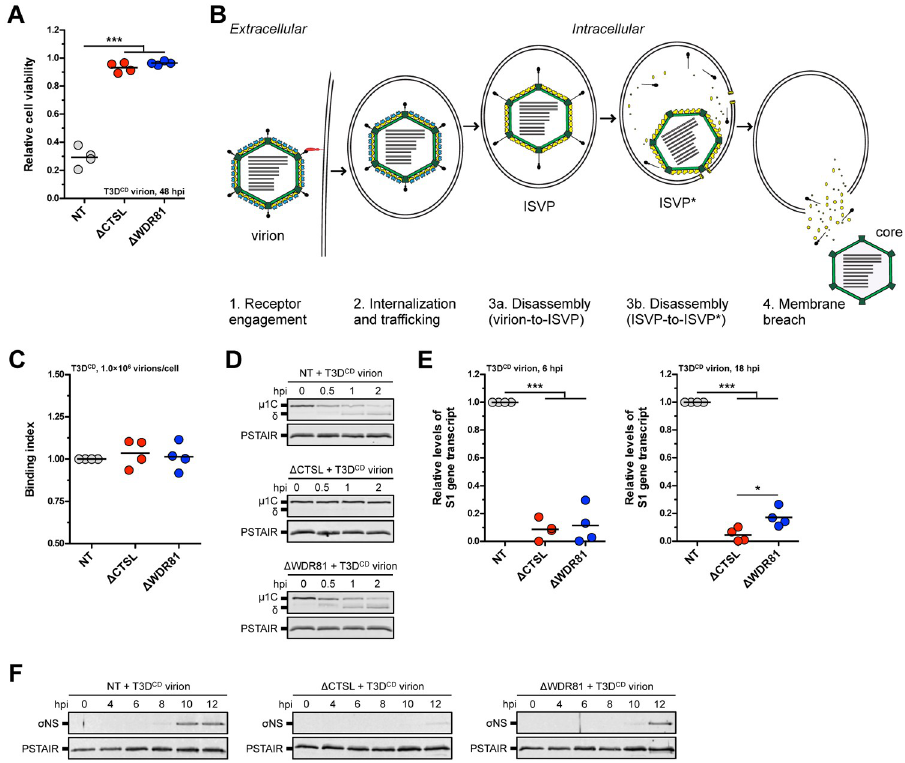
Fig 2. Infection of WDR81-deficient cells by T3D CD . (A) Induction of cell death. NT, Δ CTSL, and Δ WDR81 cells were infected with T3D CD virions at 5 PFUs/cell. At 48 h post infection (hpi), the relative cell viability was measured using the CellTiter-Glo Luminescent Cell Viability Assay. Horizontal bars indicate the means; ��� , P � 0.0005 (n = 4 biological replicates). (B) Schematic of the reovirus entry pathway. (C) Viral attachment. NT, Δ CTSL, and Δ WDR81 cells were adsorbed with T3D CD virions at 1.0 × 10 6 particles/cell, and the binding index was measured using indirect immunofluorescence. Horizontal bars indicate the means (n = 4 biological replicates). (D) Viral disassembly (virion- to-ISVP). NT, Δ CTSL, and Δ WDR81 cells were infected with T3D CD virions at 1.0 × 10 3 particles/cell. At the timepoints indicated in the figure, the levels of the reovirus μ 1C and δ proteins and the PSTAIR epitope of the host protein Cdk1 were measured by Western blot. The migration of μ 1C, δ , and PSTAIR are indicated on the left (n = 3 biological replicates; results from 1 representative experiment are shown). (E) Viral RNA transcription. NT, Δ CTSL, and Δ WDR81 cells were infected with T3D CD virions at 5 PFUs/cell. At 6 and 18 hpi, the levels of the reovirus S1 gene transcript were measured using quantitative reverse transcription-PCR. Horizontal bars indicate the means; � , P � 0.05, ��� , P � 0.0005 (n = 4 biological replicates). (F) Initiation of viral protein synthesis. NT, Δ CTSL, and Δ WDR81 cells were infected with T3D CD virions at 5 PFUs/cell. At the timepoints indicated in the figure, the levels of the reovirus σ NS protein and the PSTAIR epitope of the host protein Cdk1 were measured by Western blot. The migration of σ NS and PSTAIR are indicated on the left (n = 3 biological replicates; results from 1 representative experiment are